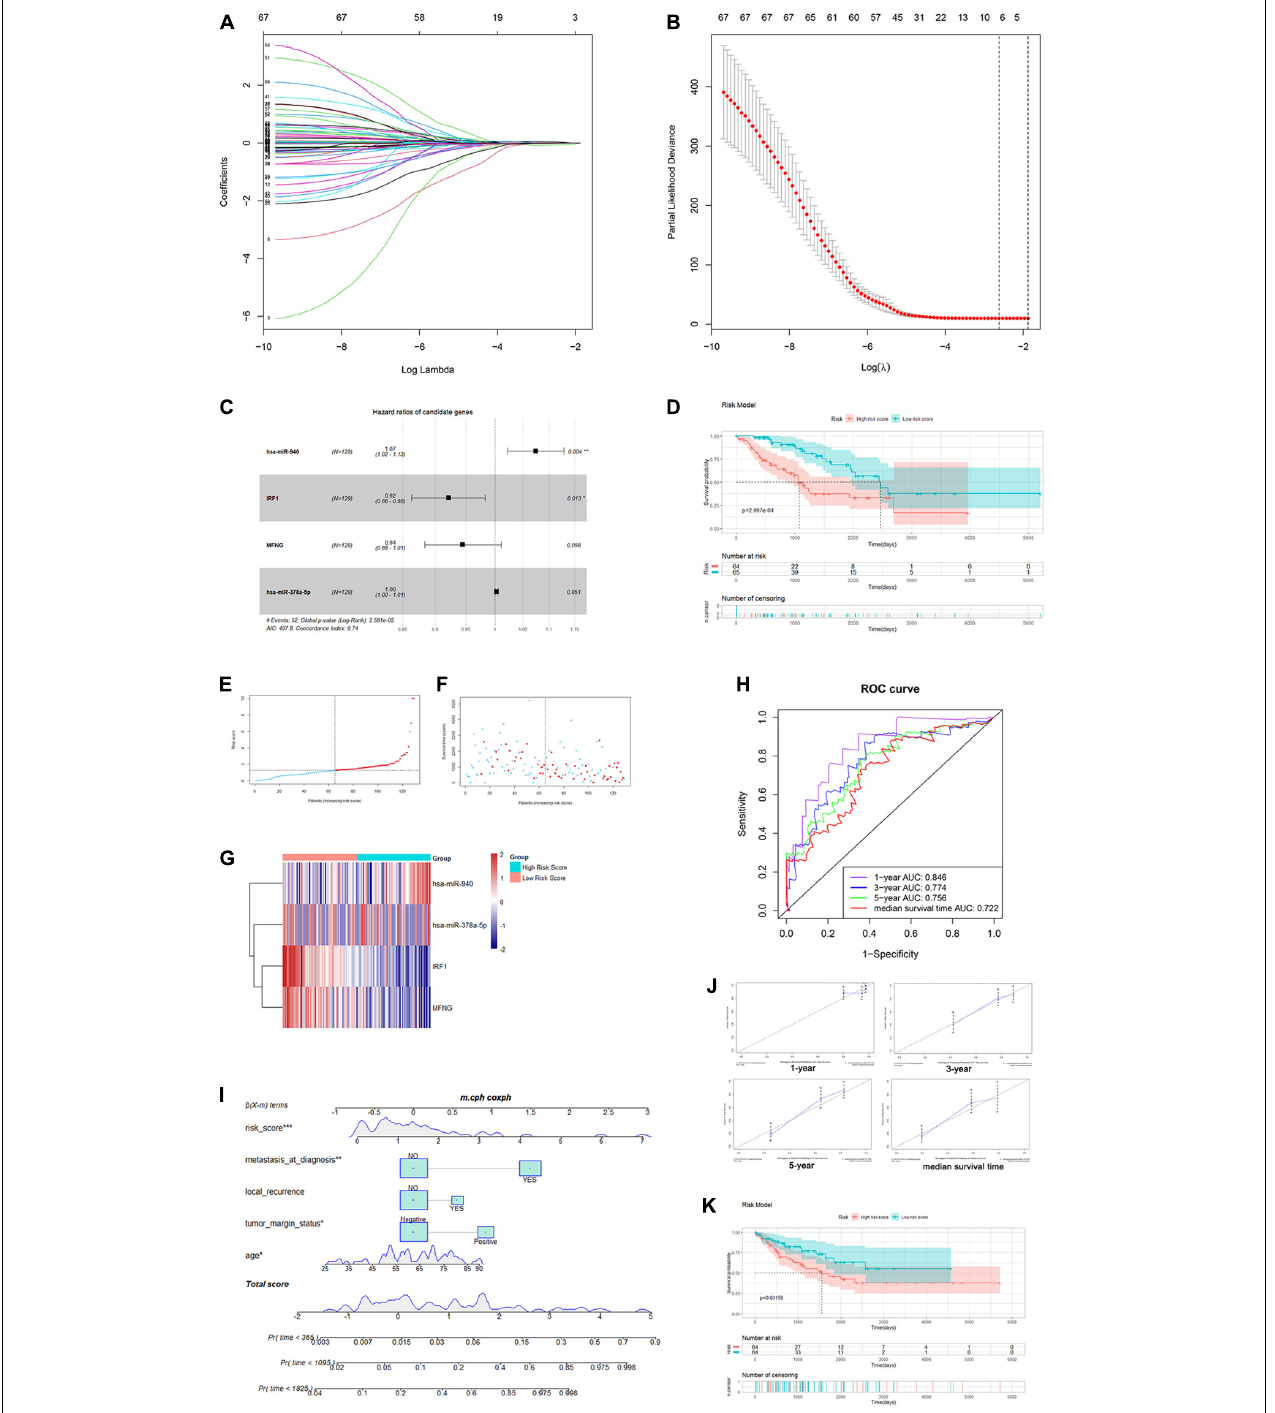
FIGURE 7 | Construction of the immune infiltration-related risk score model and nomogram. (A,B) Plots for Lasso Cox regression analysis of genes identified by univariate Cox regression analysis. (C) Forest plot for the four genes in the most optimal model confirmed by multivariate Cox regression using the analytical method. (D) K–M survival analysis of training-cohort overall survival based on risk scores. (E–G) The risk score curve, survival status, and gene expression levels for each patient were discretely distributed in two groups. (H) Time-dependent ROC curves of the risk score model for predicting the survival probability of 1-, 3-, and 5-year and median-survival time overall survival. (I) Nomogram for predicting the survival probability of 1-, 3-, and 5-year overall survival. (J) The time-dependent calibration plots for the nomogram in the 1-, 3-, and 5-year time periods. (K) K–M survival analysis of testing-cohort overall survival according to risk score level.